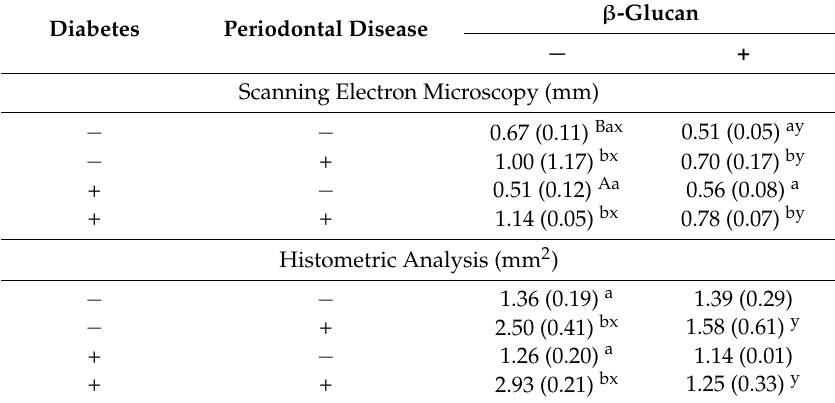
Table 4. Alveolar bone loss (mean ± standard deviation) by two different methods in animals with diabetes and/or periodontal disease treated or not treated with β -glucans at a dose of 30 mg/kg/day for 28 days.